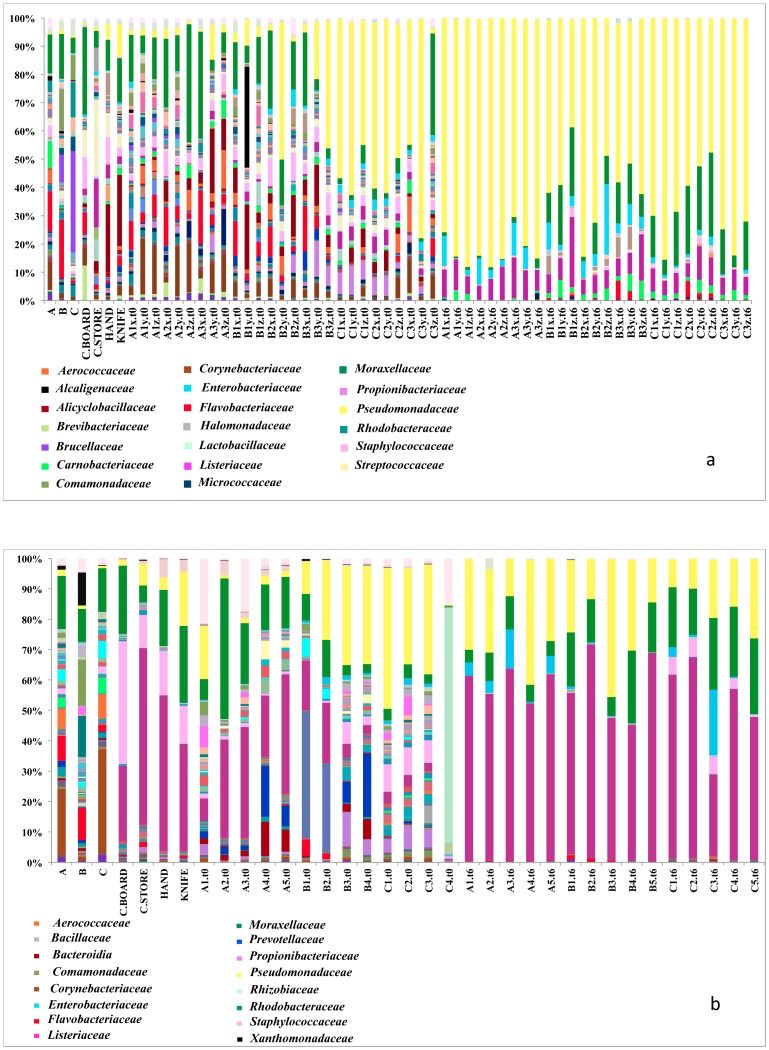
Abundance of bacterial families in carcass swabs, environmental swabs, beefsteaks at time zero (t0) and after one week of aerobic storage at 4°C (t6) in experiment 1 (panel a) and experiment 2 (panel b).Beefsteaks samples are labeled according to the beef cut of origin: A, brisket; B, chuck; C, thick-flank. Color key legend shows only bacterial families with >8% abundance.